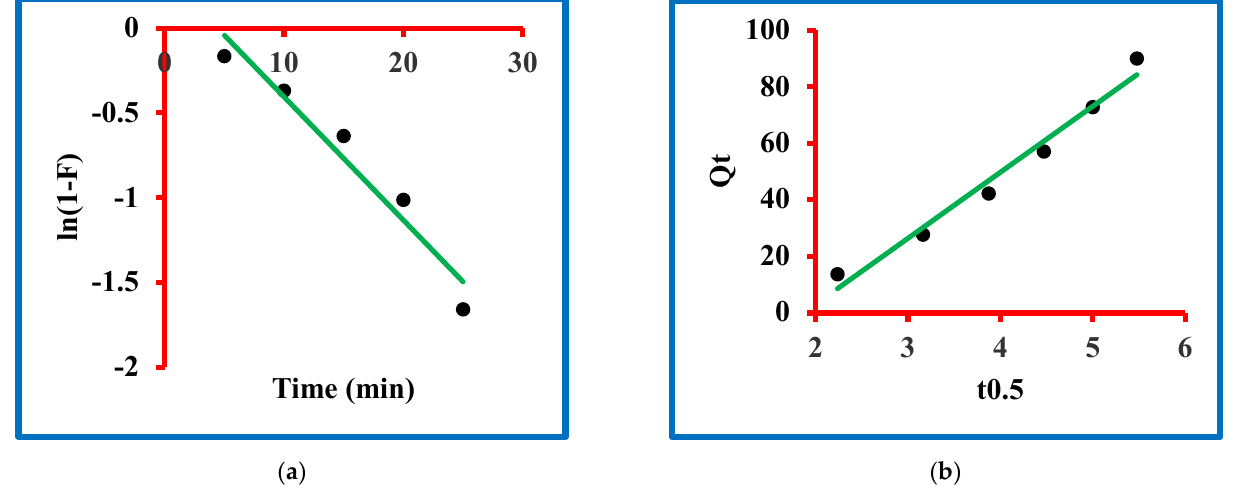
Figure 7. Mechanism of the sorption: ( a ) liquid-film diffusion and ( b ) intra-particular diffusion models. Table 3. The values of the uptake mechanism parameters of triclosan. The Kinetic Models and Parameters Numerical